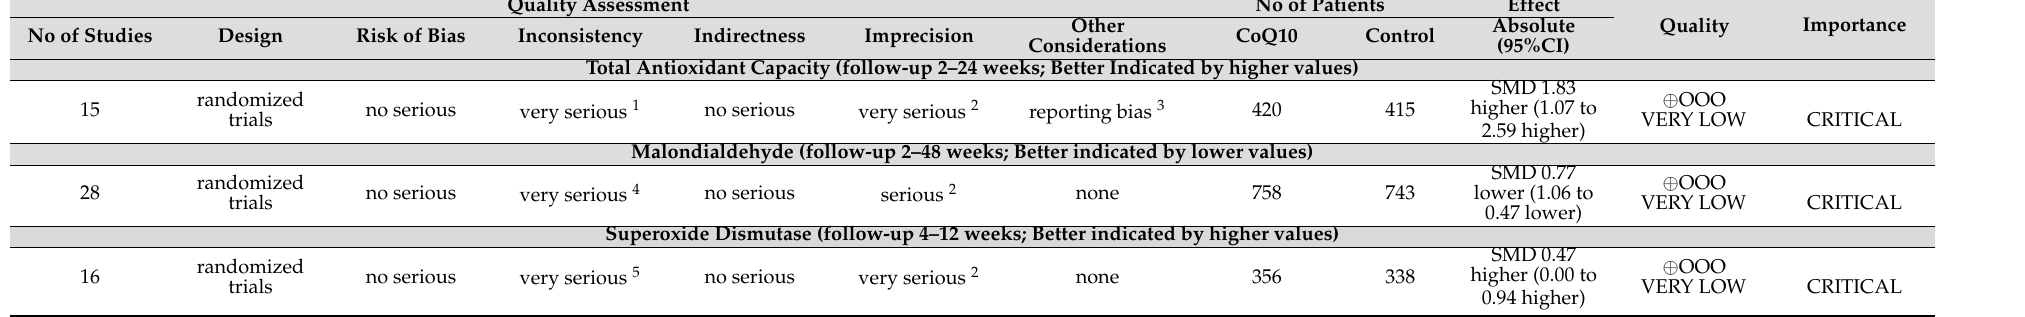
Table A2. GRADE evidence profile of CoQ10 supplementation on oxidative stress